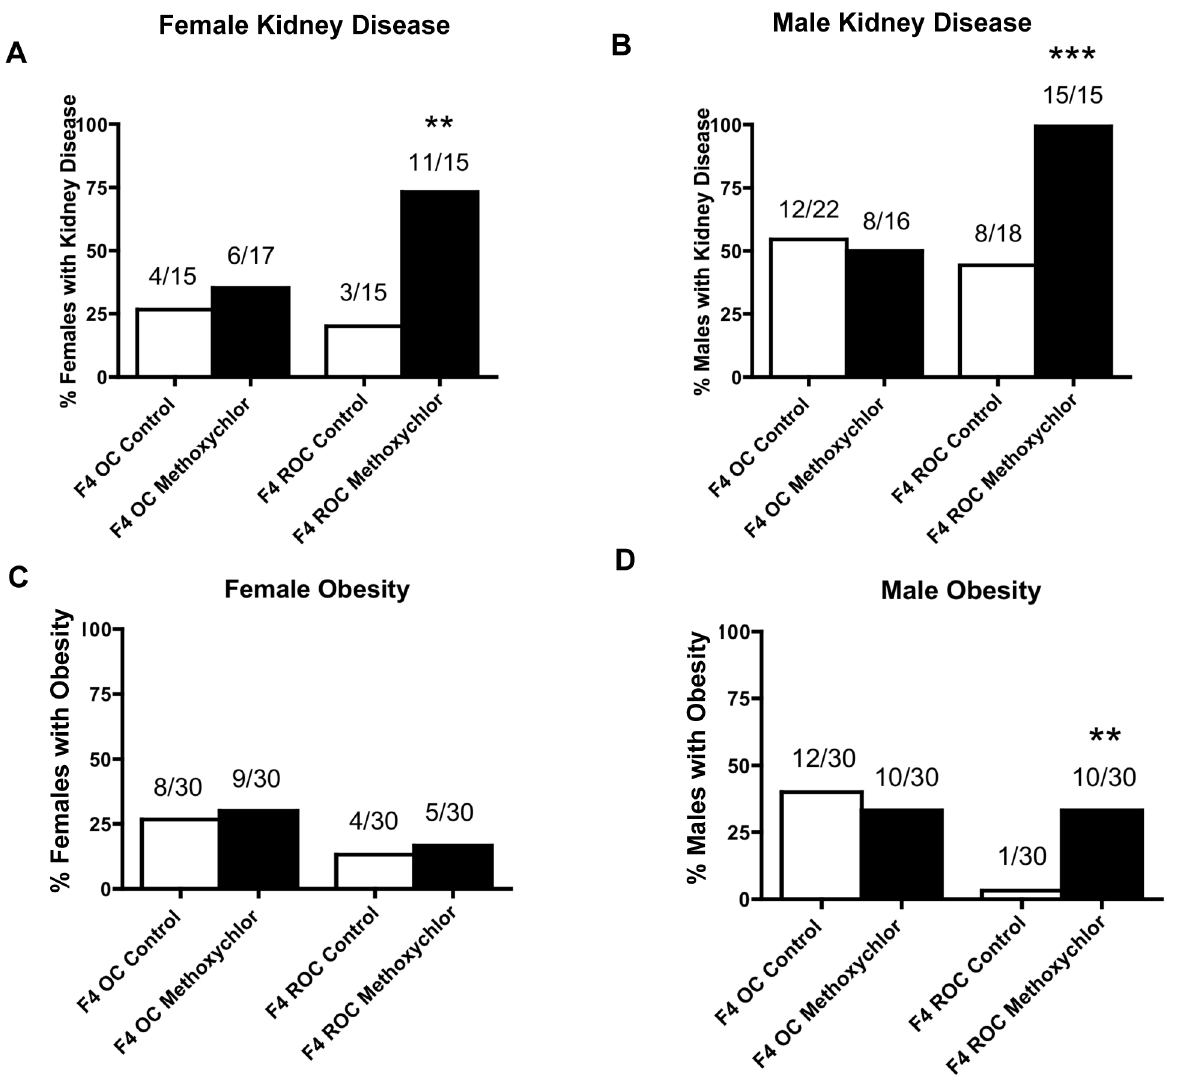
Figure 5. Ancestral exposure to methoxychlor promoted adult-onset transgenerational diseases in F4 generation reverse outcross offspring showing female germline transmission. Incidences of kidney disease in females (panel A), in males (panel B), obesity in females (panel C) and in males (panel D) of the F4 generation outcross (OC) or reverse outcross (ROC) offspring of the control and methoxychlor lineages.